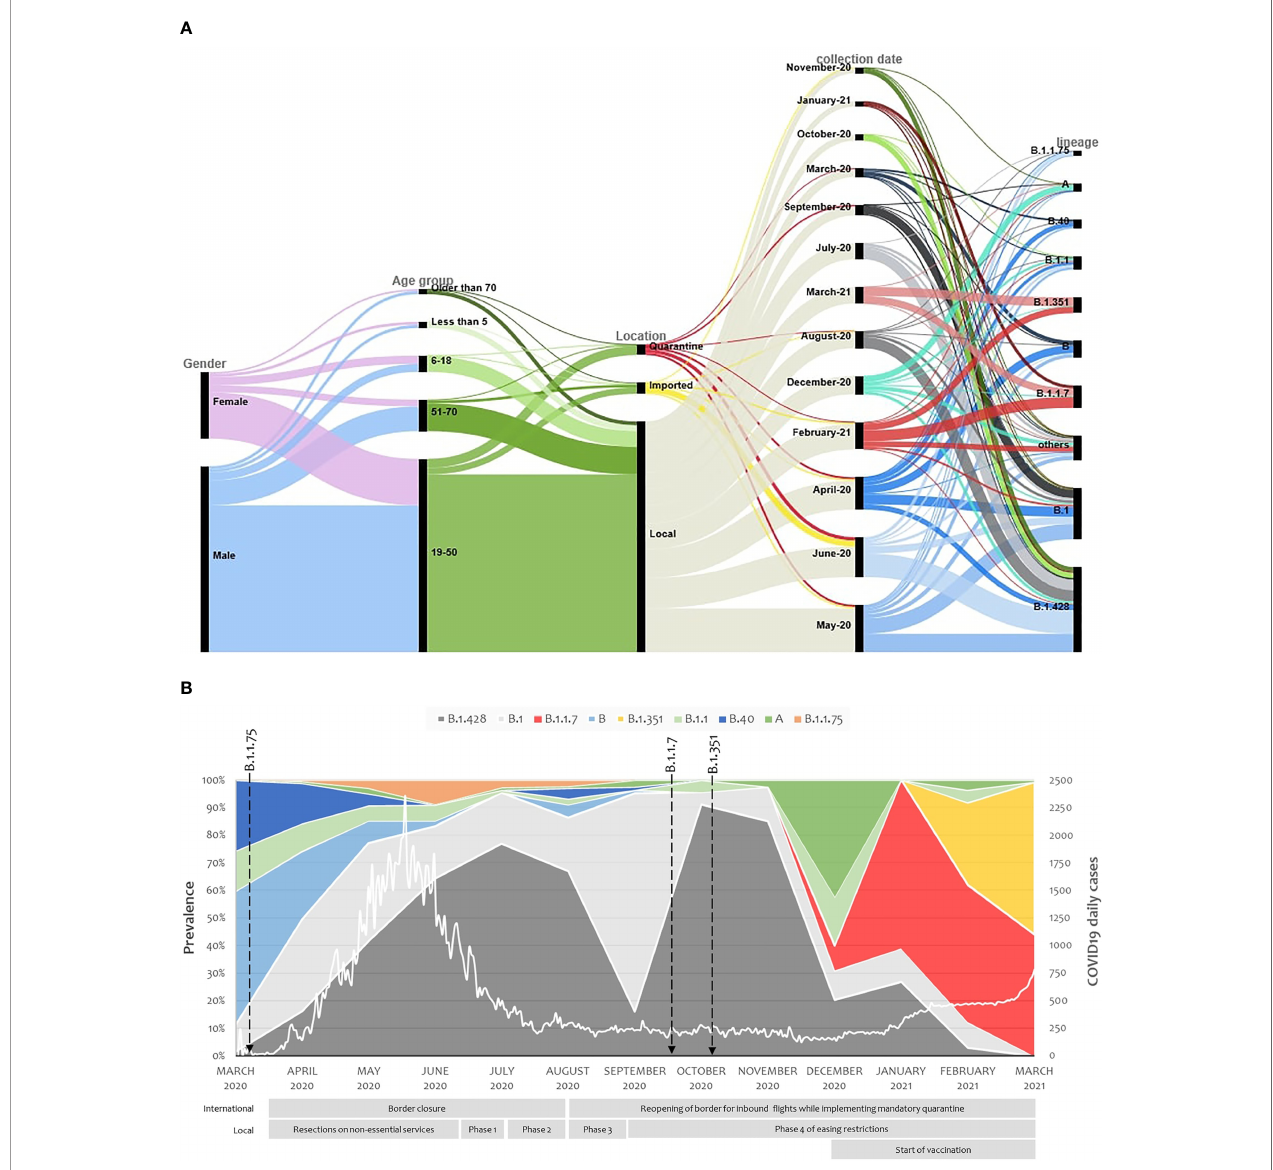
FIGURE 1 | Demographics and virological characteristics of Qatar study cohort. (A) Demographics, swab collection dates and virological parameters of the study cohort are demonstrated in an alluvial diagram with the display of relatedness among features of each two neighboring nodes. (B) SARS-CoV-2 major lineages distribution over the one-year study period from March 2020 to March 2021. Arrows represent when the designated lineages were reported worldwide. The white line demonstrates the daily COVID19 positive cases in Qatar. The international and national restrictions implemented by the country is presented below the stacked area